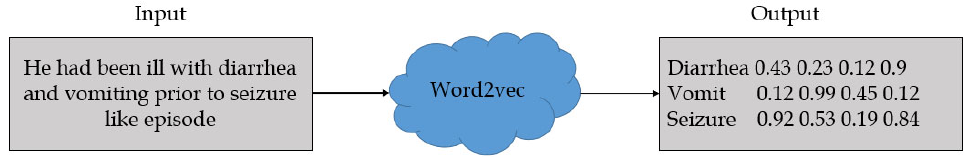
Figure 1. word2vector process.